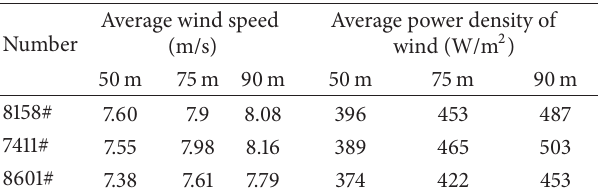
Table 5: Power density of wind and wind speed of three meteoro- logical